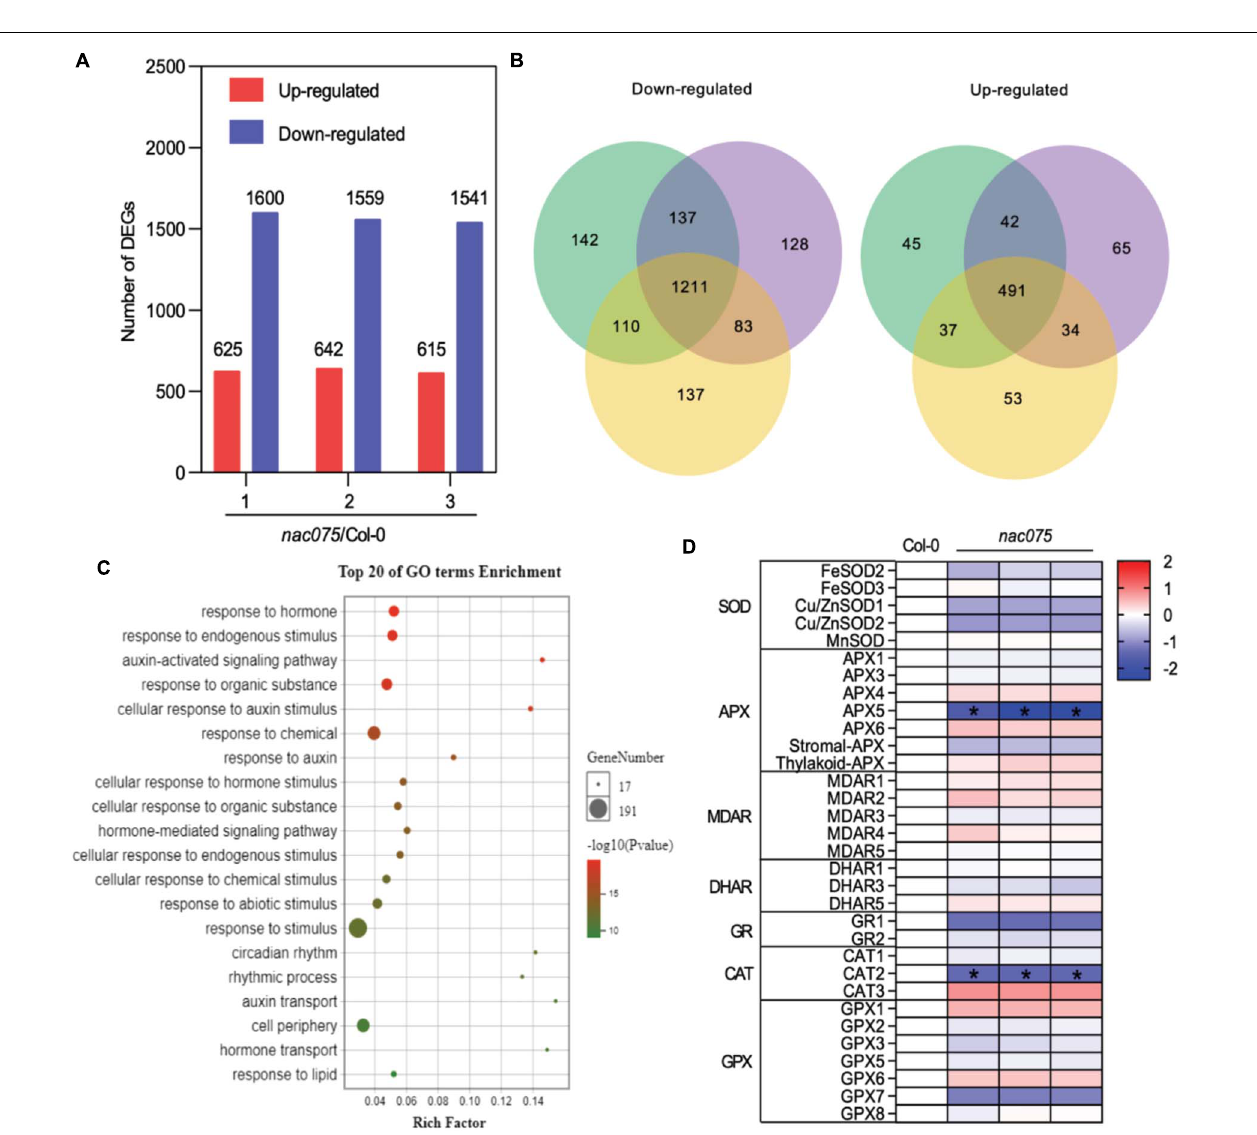
FIGURE 3 | Genome-wide transcriptome analysis of nac075 mutant plants. (A) The number of up-regulated and down-regulated genes in three biological replicates of nac075 mutant plant rosette leaves vs. Col-0 with RNA-seq. Red represents up-regulated genes, and blue represents down-regulated genes. (B) Schematic of the Venn diagram analysis of common down-regulated and up-regulated genes [DEG; | Log2 (FC)| > 1, FDR < 0.05] in three nac075 mutant plant leaves relative to the Col-0 control. (C) GO bubble diagram of down-regulated genes among the DEGs in three nac075 rosette leaf samples. The bubble size represents the number of DEGs, and the bubble color represents the P- value. The rich factor equals the number of DEGs in a certain signaling pathway. (D) Heat map showing ROS-related genes in nac075 mutant plant rosette leaves compared to Col-0. Means of three experiments are shown. The log2 fold change scale is indicated on the right side of the heat map. SOD, superoxide dismutase; APX, ascorbate peroxidase; MDAR, monodehydroascorbate reductase; DHAR, dehydroascorbate reductase; GR, glutathione reductase; CAT, catalase; GPX, glutathione peroxidate.